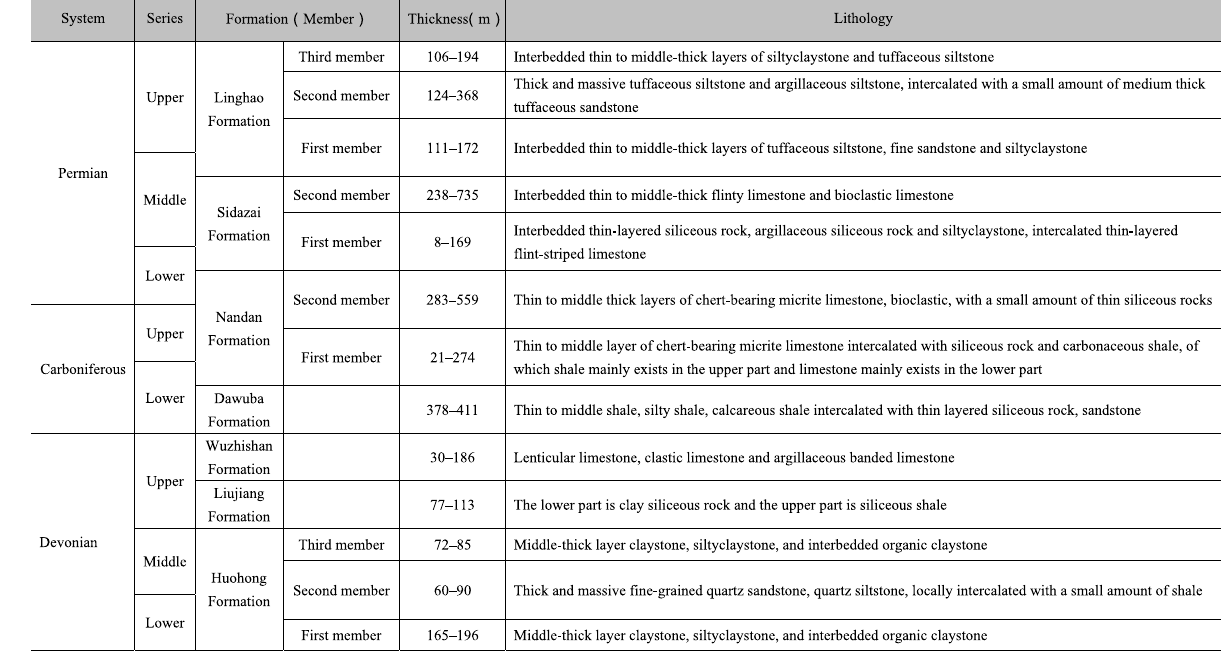
TABLE 1 | Stratigraphic division table of Upper Paleozoic in the Qiannan area.